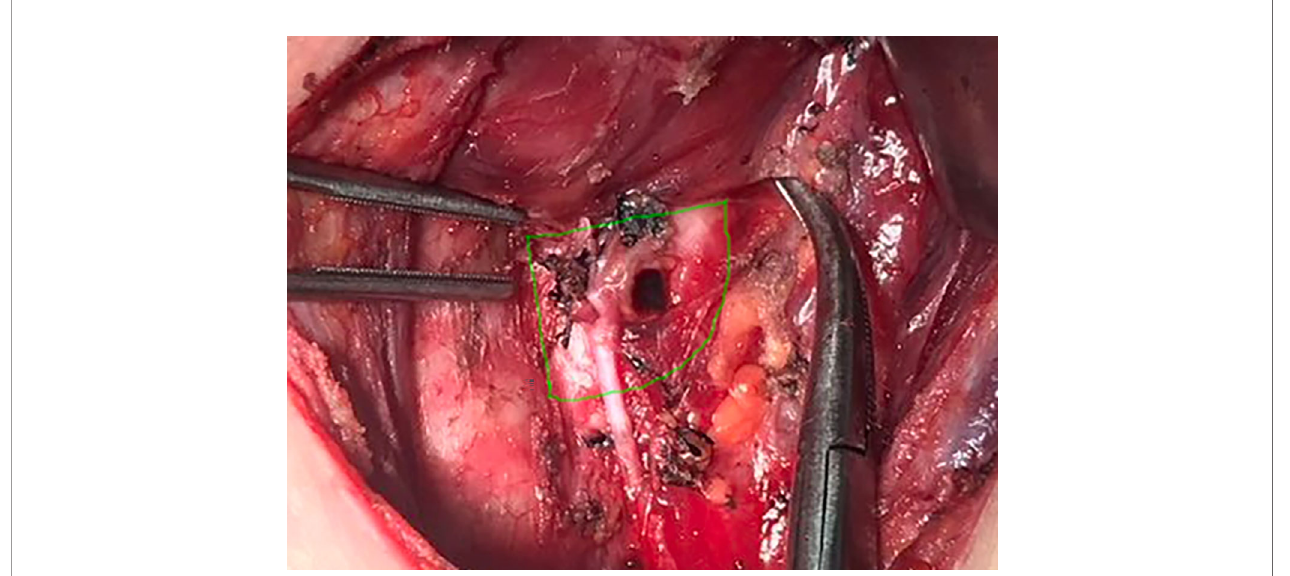
FIGURE 1 | The region of RLNIZ. Green line showed the region of RLNIZ needed to be dissected during